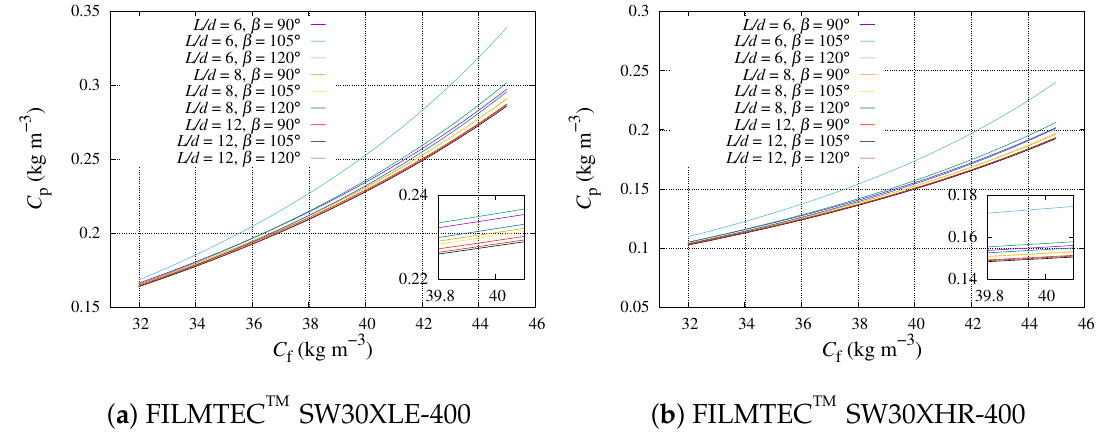
Figure 4. C p of a PV with 8 SWMMs in series considering different feed spacer geometries, a range of C f , p f = 55 bar and Q f = 12 m 3 h − 1